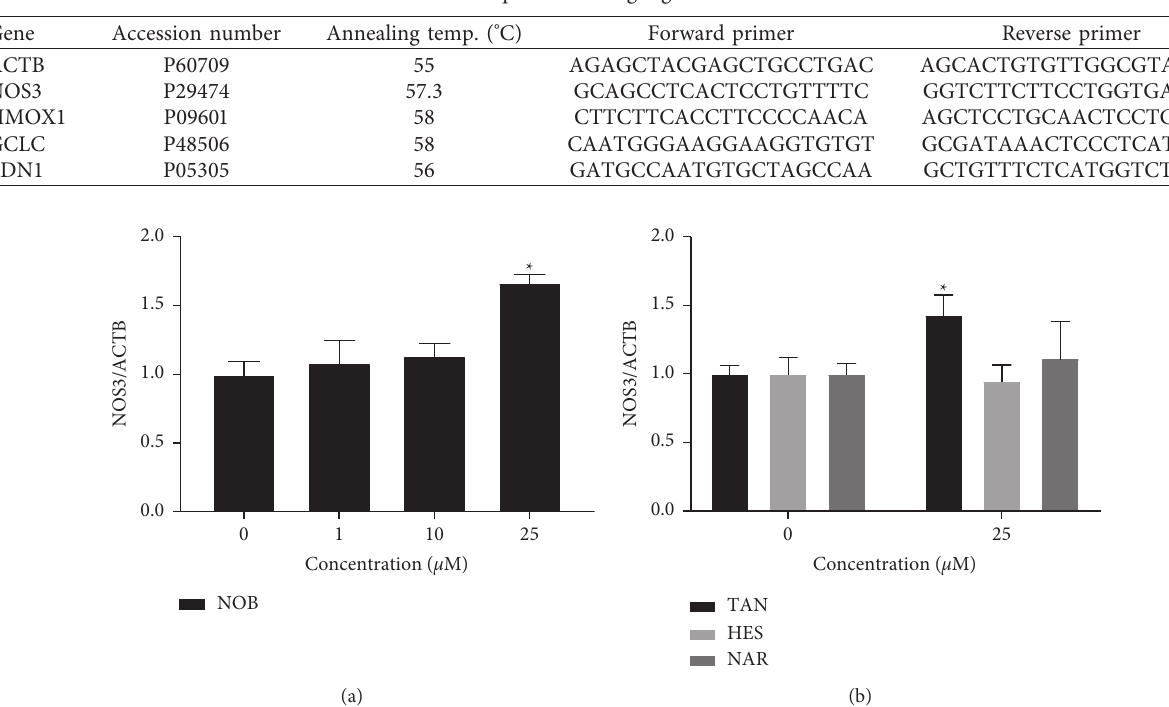
Figure 1: Effect of increasing concentrations of citrus flavonoids: (a) nobiletin (NOB) and (b) tangeretin (TAN), hesperetin (HES), and naringenin (NAR) on NOS3 mRNA levels. Cells were incubated for 18h with concentrations up to 25 μ M. Data are presented as mean ± SD. ∗ indicates significant differences between the treatment group and untreated control group at p < 0 . 05.